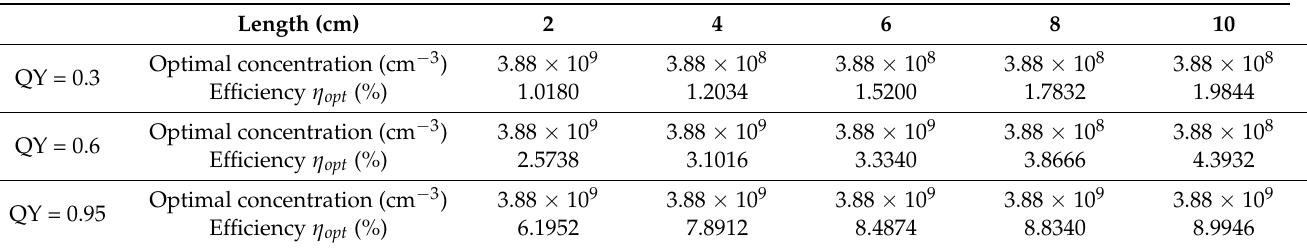
Table 2. Optimal efficiencies for different lengths and optimal concentrations in a radius of 1 cm and quantum yields of 0.3, 0.6, and